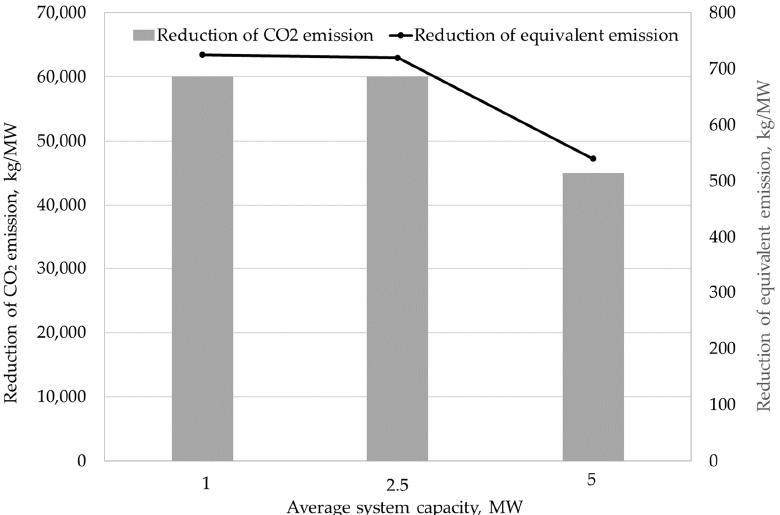
Figure 5. The size of emission reductions per 1 MW of capacity for the system for improving energy and ecological efficiency.